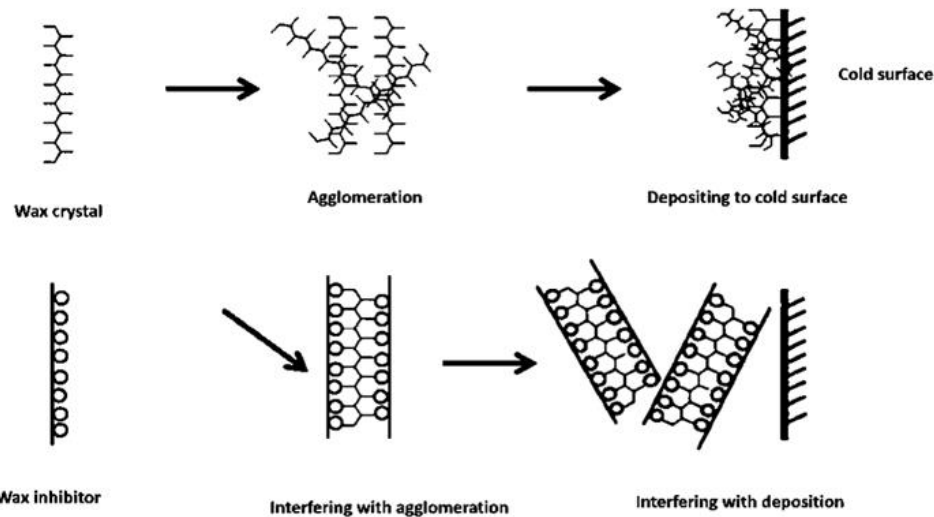
Figure 2. Schematic illustration of the co-crystallization of wax crystal modifier with wax crystals